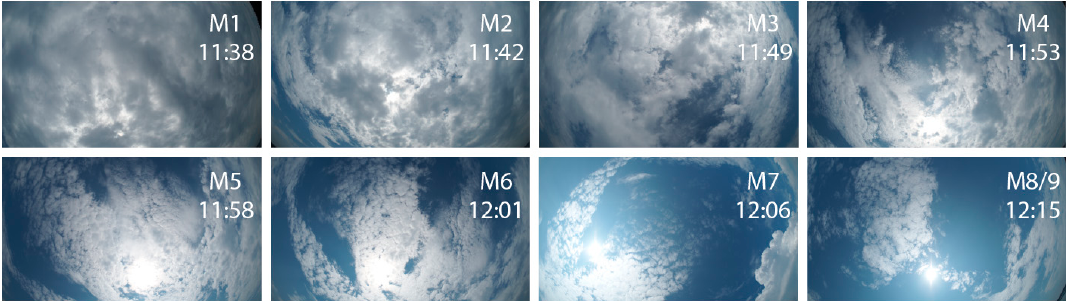
Figure 2. Photographs taken in the direction of the sun illustrating the sky conditions during the times when hyperspectral sets of measurements (M1–M9) were recorded.